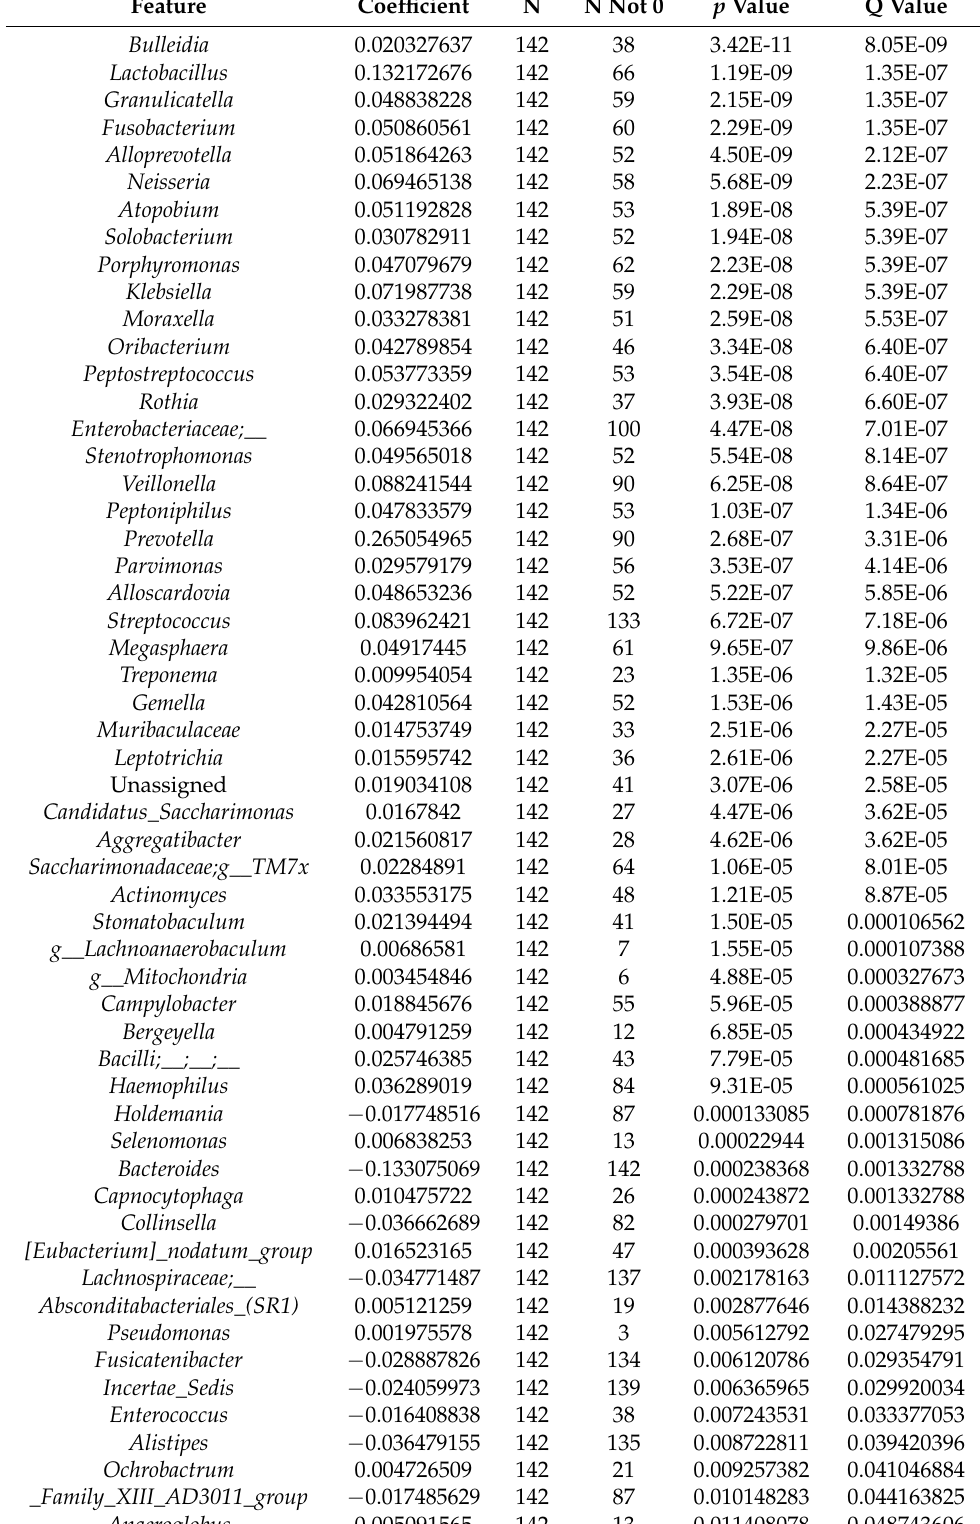
Table 2. The list of the 55 differentially abundant bacteria in the control group during the two school terms. A p -value < 0.05 was considered significant. N is the number of samples, while N. not 0 implies the samples with relative abundances more than 0. Q value (False Discovery Rate, FDR) of <0.05 was considered significant. Coefficient denotes ratio between the two